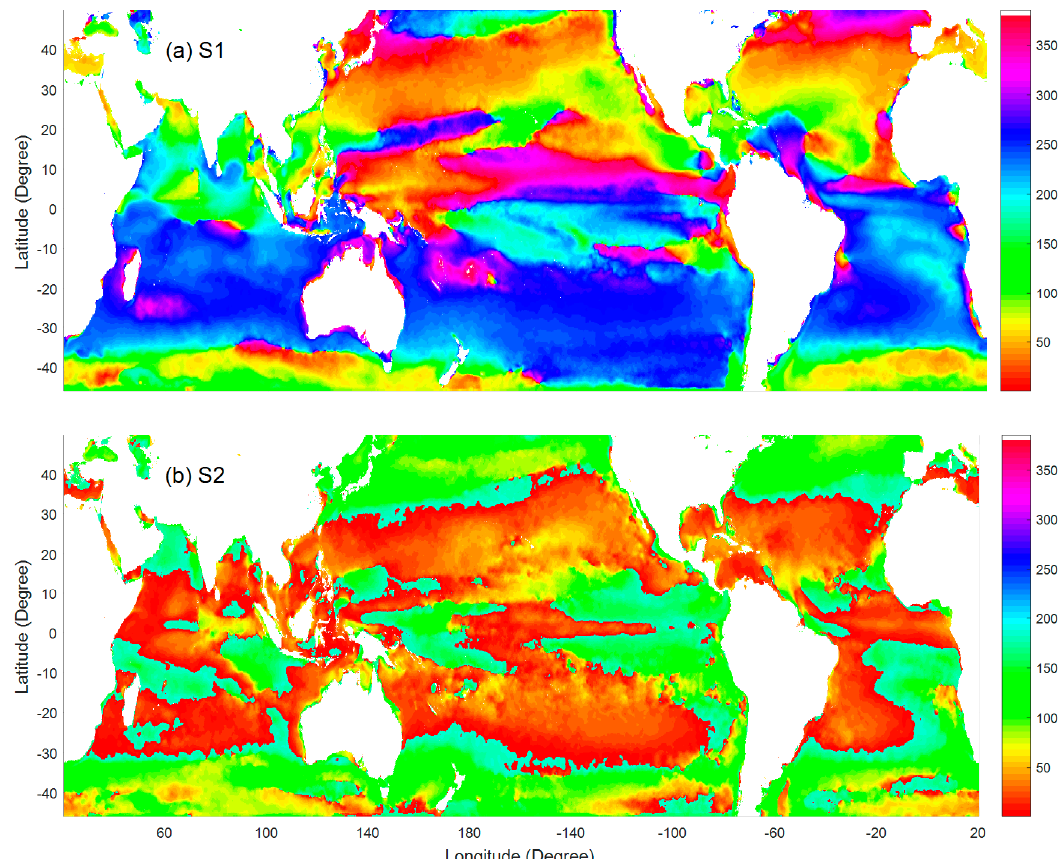
Figure 5. The phases of ( a ) and ( b ) fitted from Equation (2) in the unit of day of year.